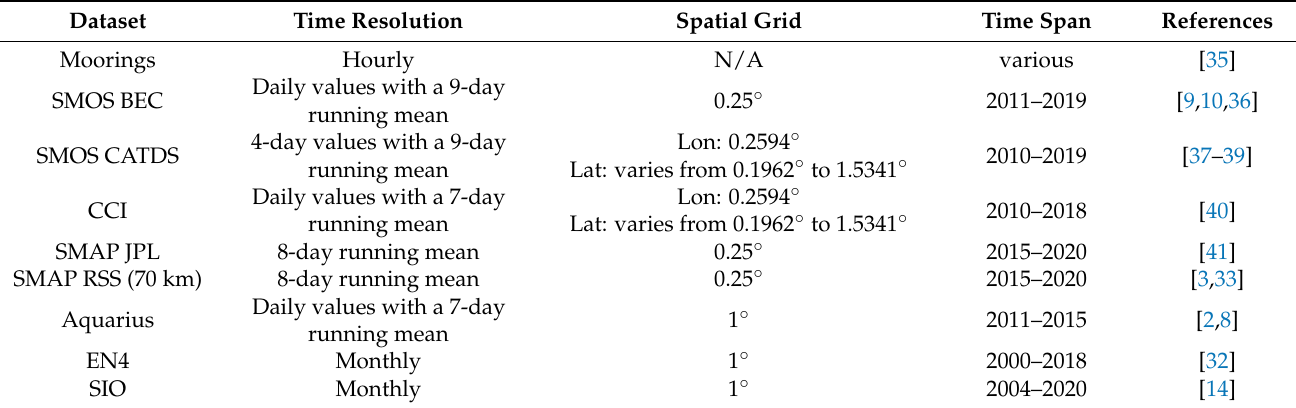
Table 1. A list of the datasets used in this study showing the time resolution, spatial grid and time span. SMOS: Soil Moisture and Ocean Salinity; BEC: Barcelona Expert Center; CTADS: Centre Aval de Traitment des Don é es; CCI: Climate Change Initiative; SMAP: Soil Moisture Active Passive; JPL: Jet Propulsion Lab; RSS: Remote Sensing Systems; SIO: Scripps Institution of